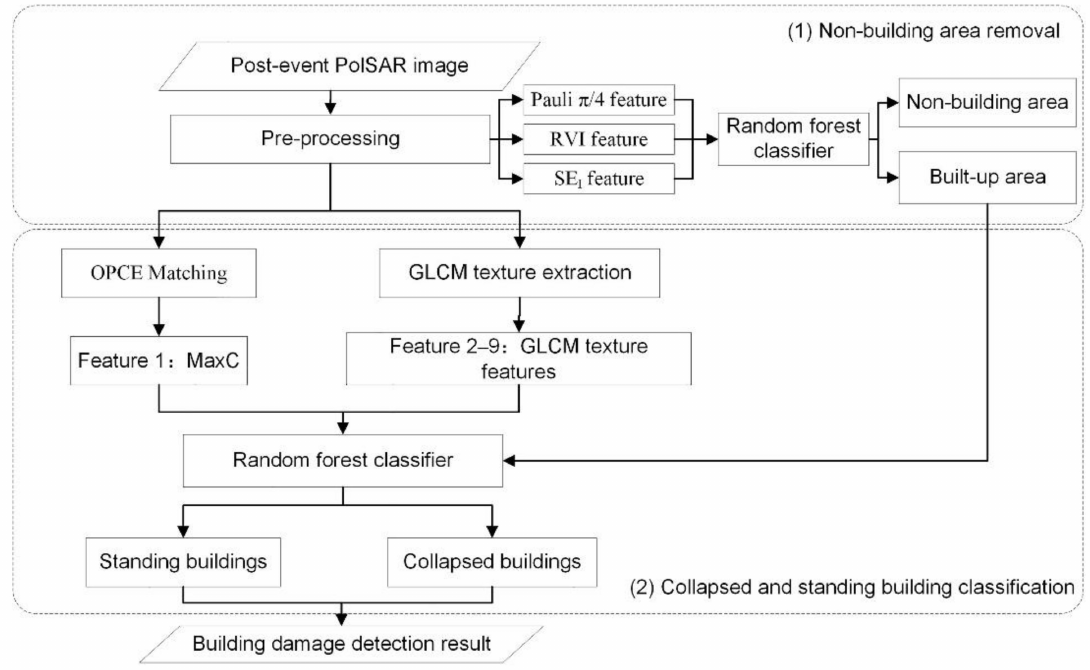
Figure 8. Flowchart of the proposed building damage detection method. PolSAR, polarimetric synthetic aperture radar; OPCE, optimization of polarimetric contrast enhancement; GLCM, gray level co-occurrence matrix; RVI, the radar vegetation index (RVI); SEI, the intensity component of the Shannon